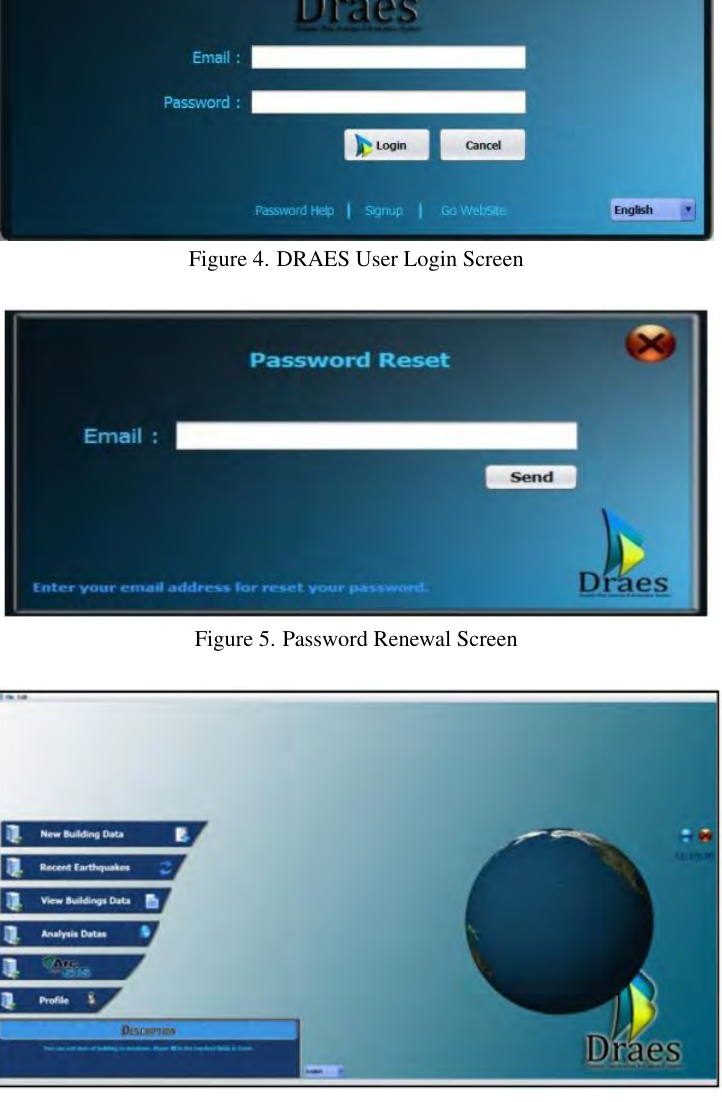
Figure 6. DRAES Main